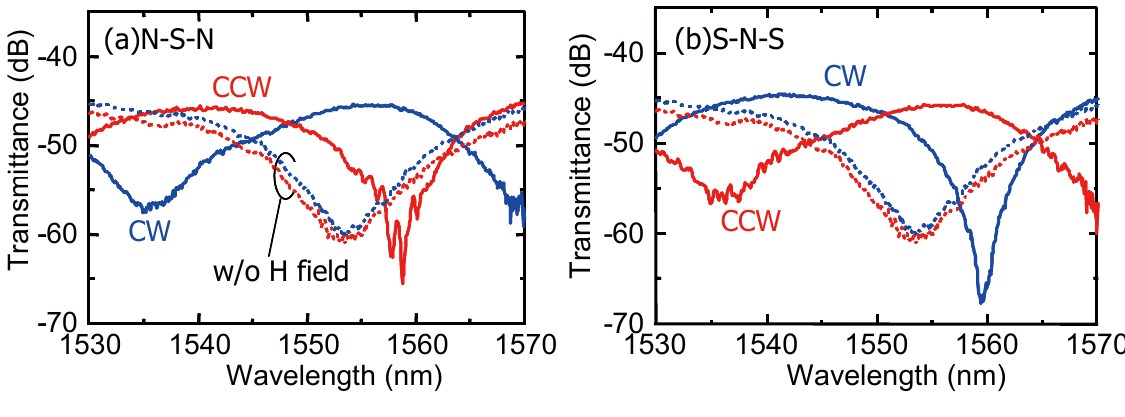
Figure 7. Measured fiber-to-fiber transmittance of a fabricated SOI interferometric waveguide optical isolator with the applied magnetic field by ( a ) N-S-N and ( b ) S-N-S three-pole permanent magnets [46]. Dotted lines show the transmittance without applying a magnetic